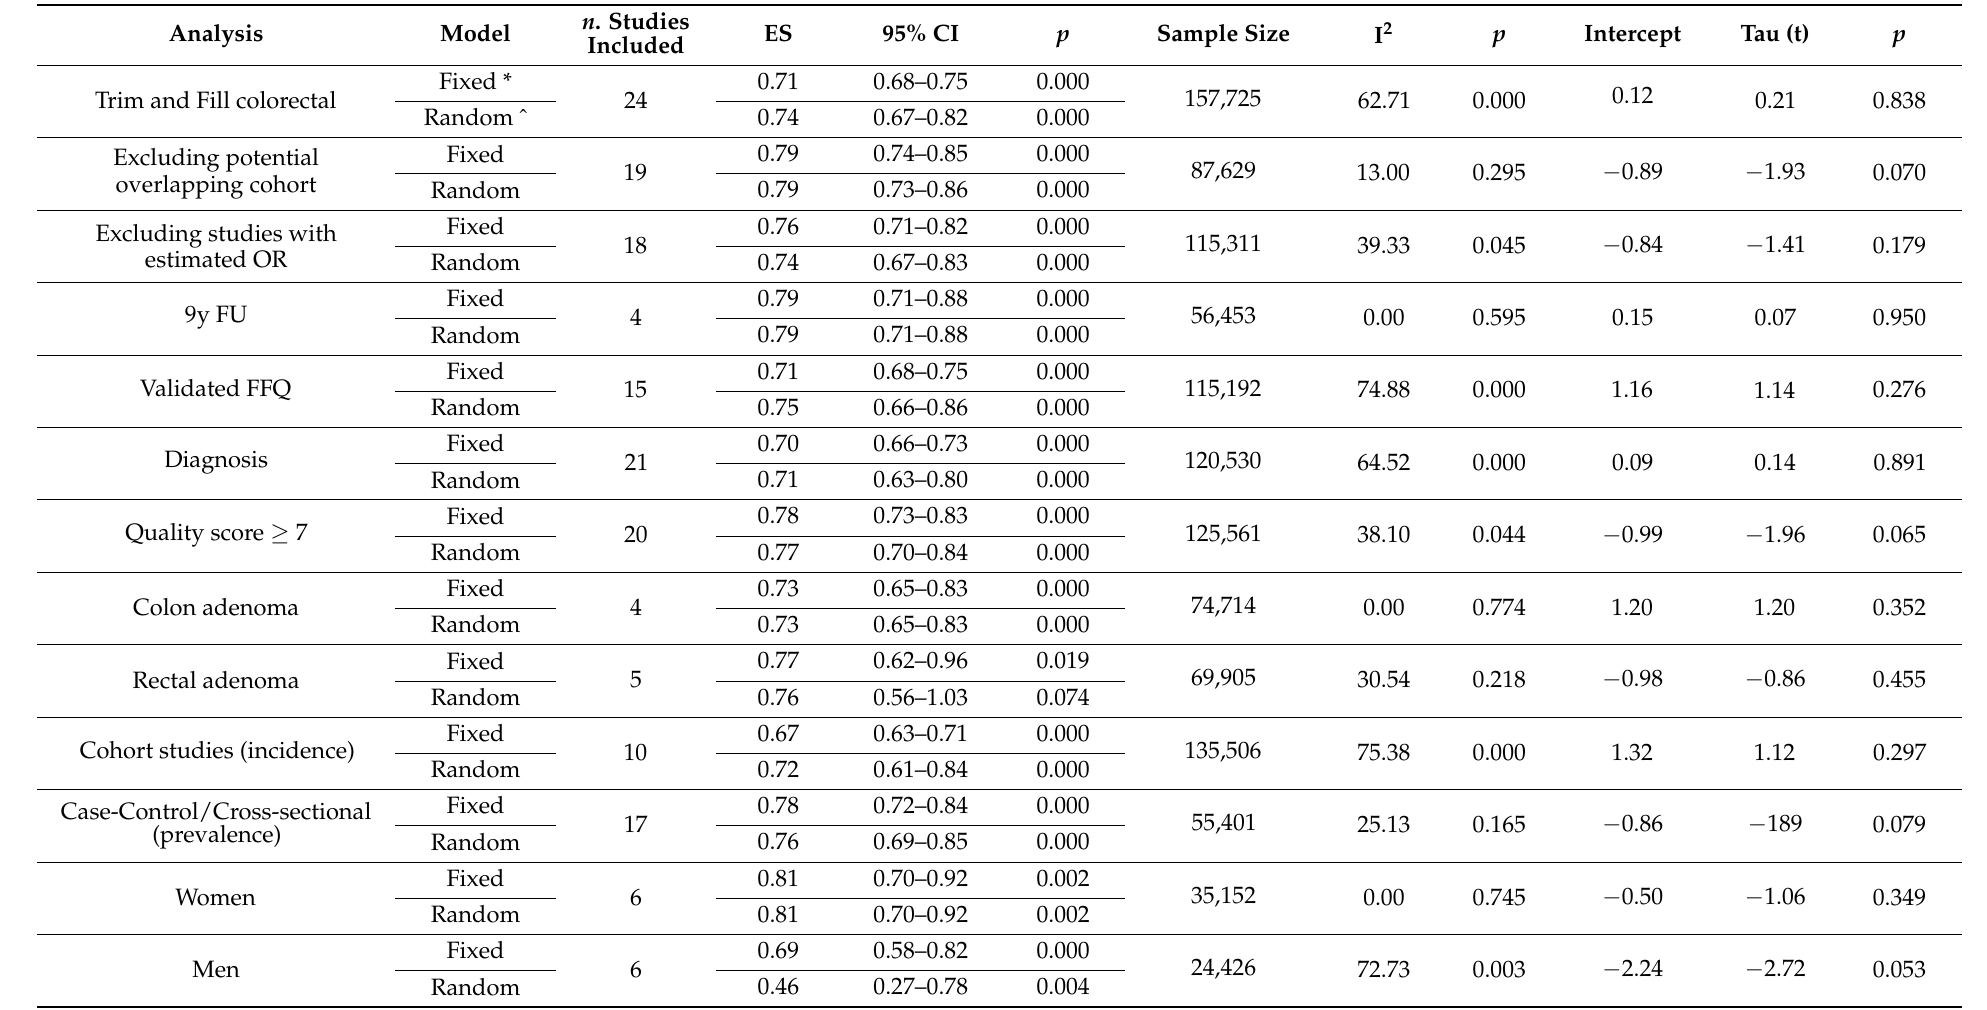
Table 3. Results of the sensitivity and subgroup